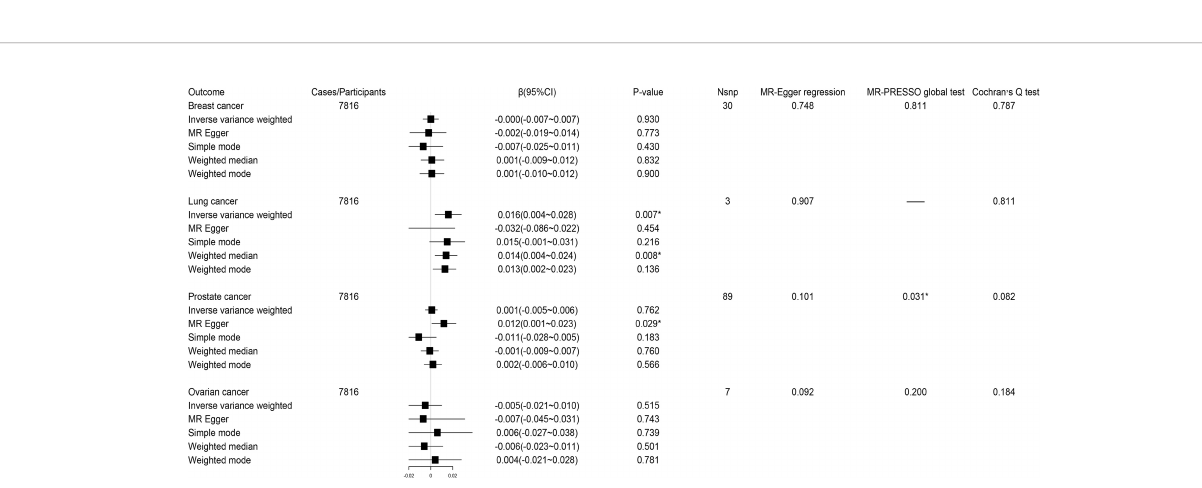
FIGURE 5 | Forest plot for associations between site-speci fi c cancers and circulating kynurenine levels. b , beta value; CI, con fi dence interval; Nsnp, number of the SNPs; *P <